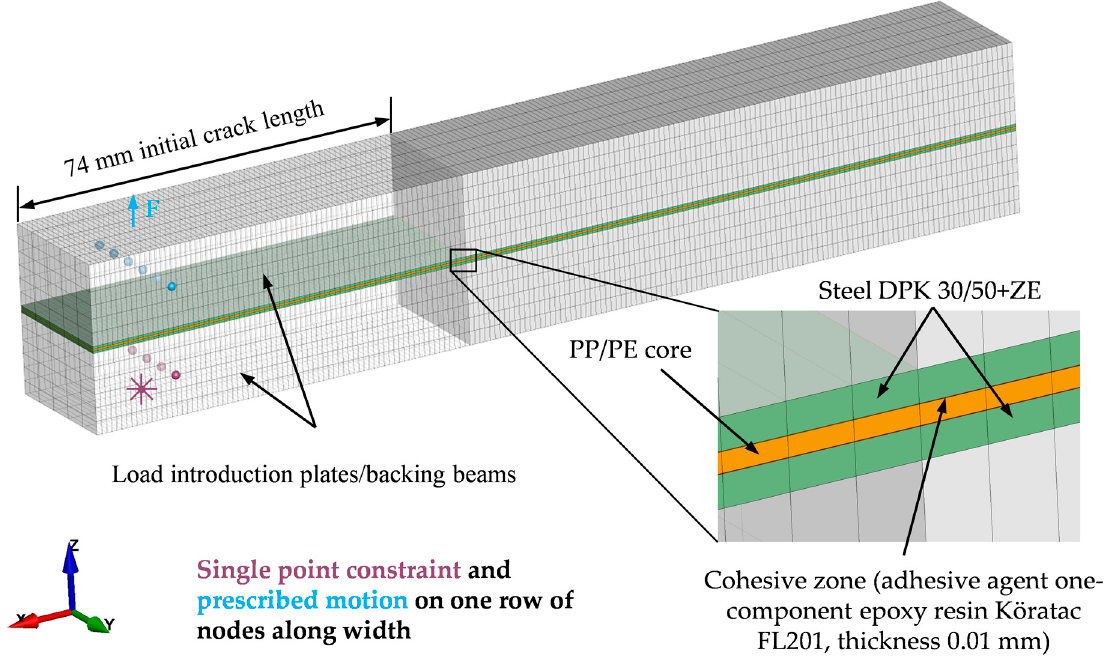
Figure 11. Simulation models of MPM specimens with adhesive crack propagation.